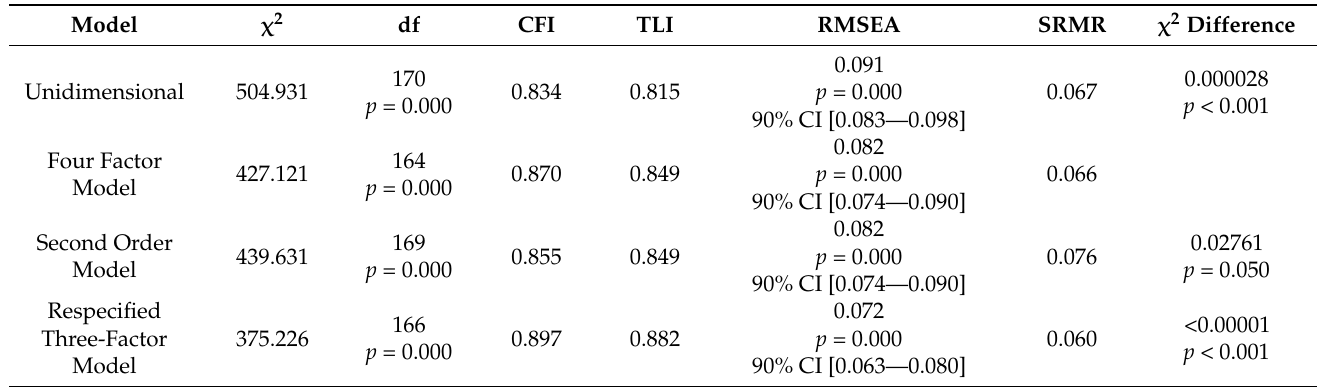
Table 2. Global Fit Indices for CFA Models.